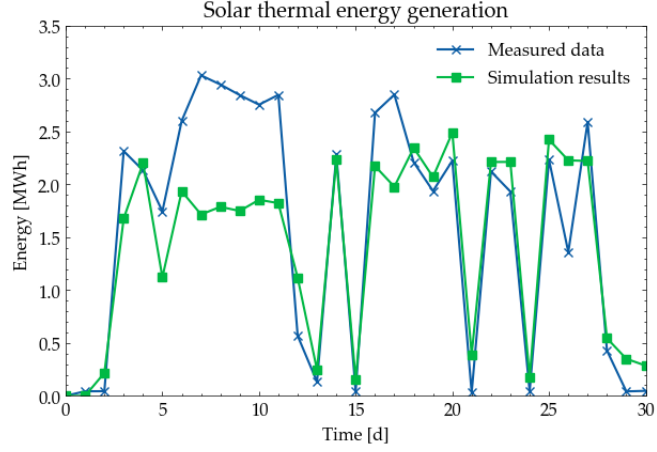
Figure 12. Thermal grid validation against solar energy generation measurements.